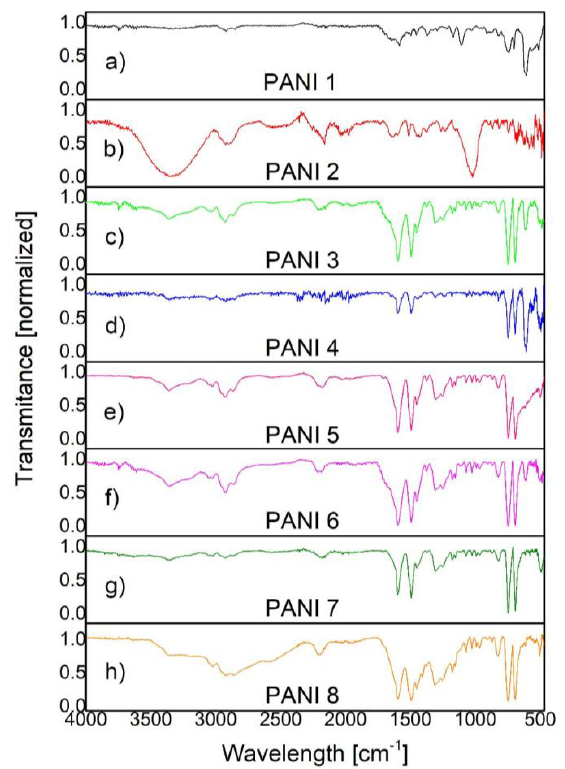
Figure 7. FTIR spectra of: ( a ) PANI 1; ( b ) PANI 2; ( c ) PANI 3; ( d ) PANI 4; ( e ) PANI 5; ( f ) PANI 6; ( g ) PANI 7; and ( h ) PANI 8.